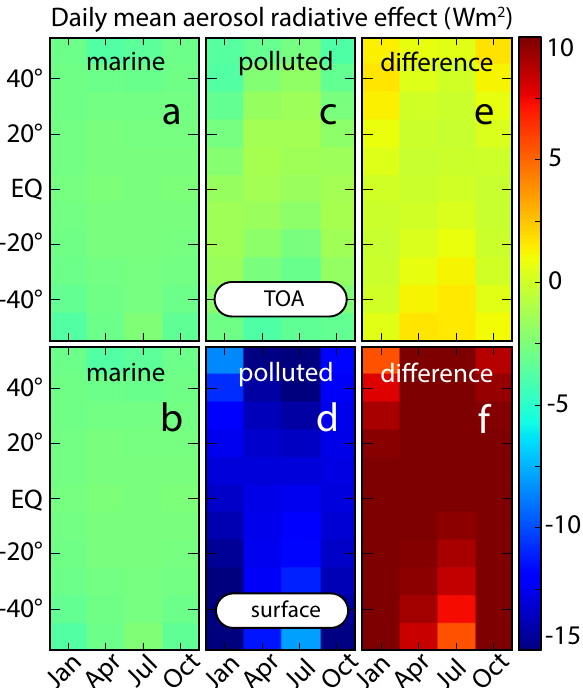
Figure 9. Direct solar aerosol radiative effect at the top of the atmo- sphere (TOA, top panel) and surface (bottom panel) for marine and polluted boundary-layer aerosol (left and center). Right: difference in the direct solar radiative effect of both aerosol scenarios.